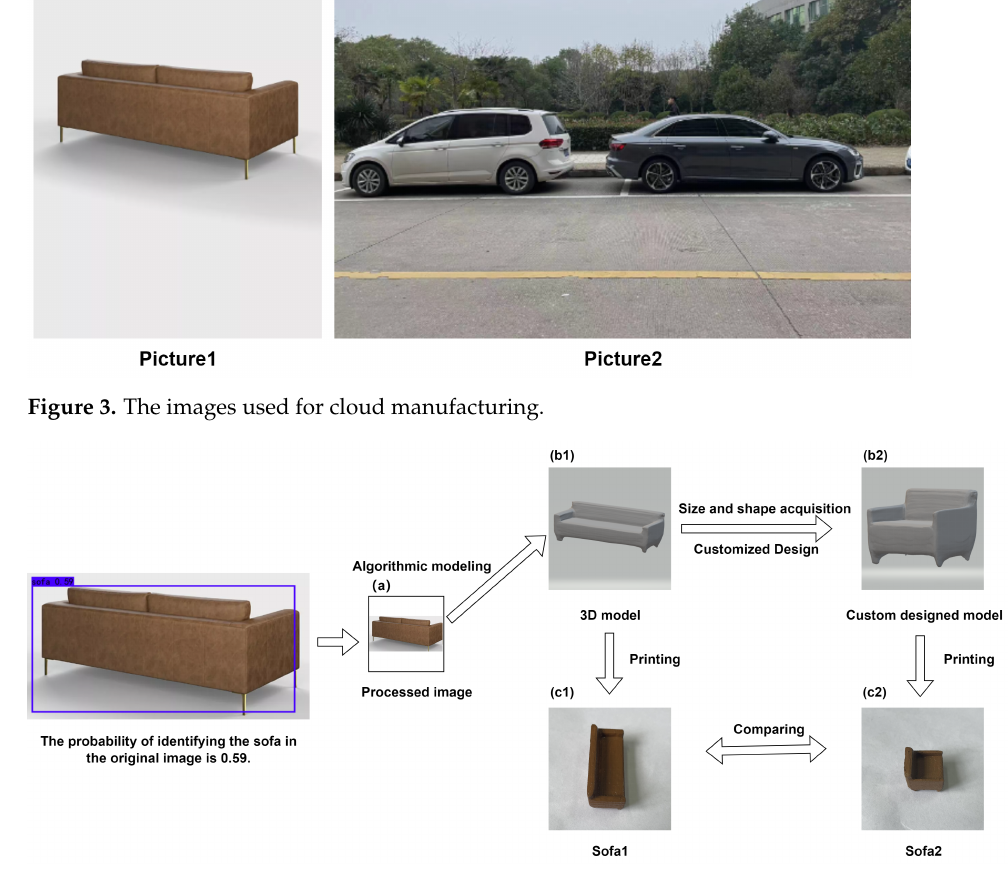
Figure 4. Two small sofa models with different shapes are manufactured using the proposed